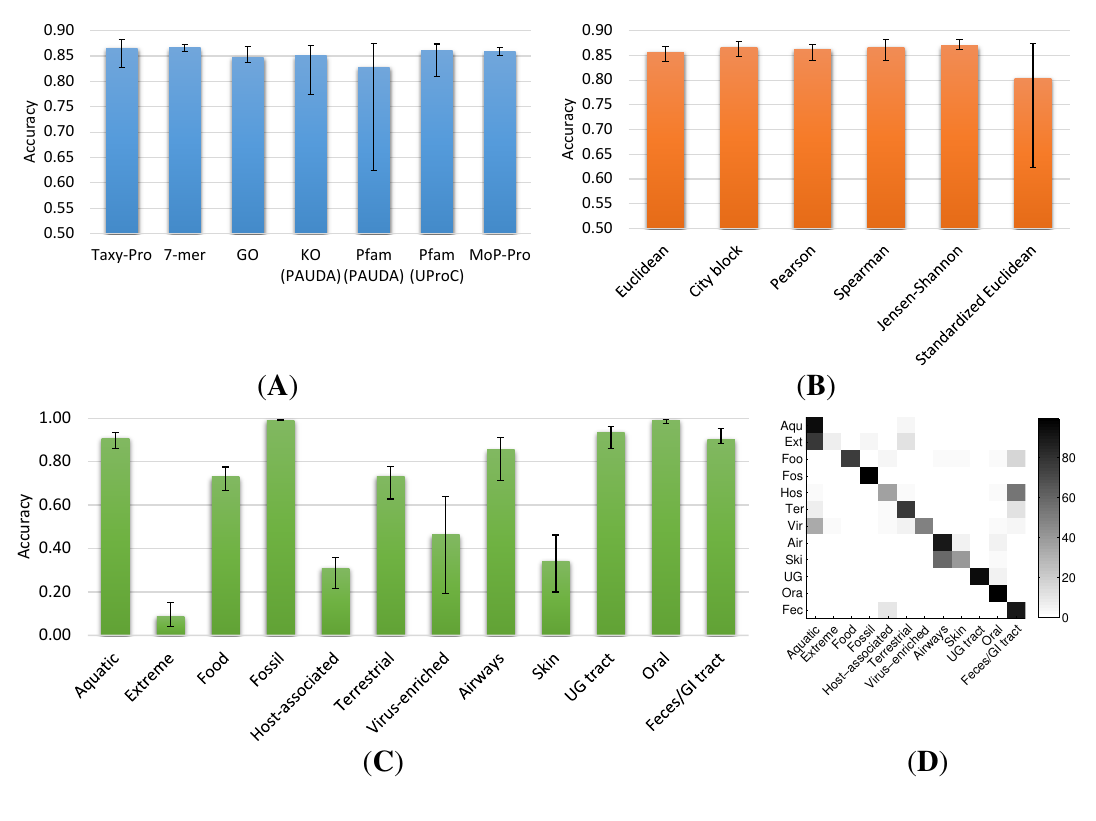
Figure 2. Neighborhood accuracy on metagenome universe collection for different methods and habitats. ( A ) Accuracy of profiling methods with average/minimum/maximum over six different metrics; ( B ) Accuracy of distance metrics with average/minimum/maximum over all seven profiling methods; ( C ) Habitat-specific accuracy for City block metric averaged over seven profiling methods; ( D ) Heatmap of confusion matrix for different habitats according to UProC protein domain profiles and City block metric. Habitat labels on y -axis abbreviated to three